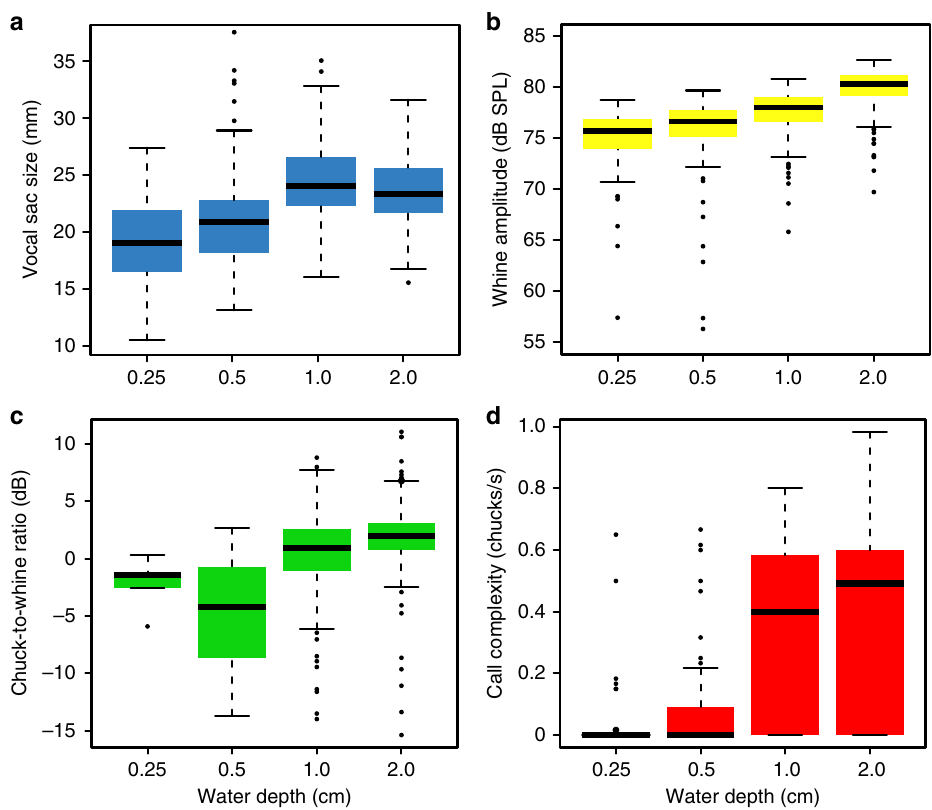
Fig. 1 Water depth limits signal production. Water depth treatment in fl uenced vocal sac width at maximum in fl ation a . Males in fl ated their sacs (and lungs) to lesser extent in shallow water. Water depth treatment also affected peak-to-peak amplitude of the whine component of the call ( b ), the chuck-to-whine ratio ( c ), as well as the total number of chucks produced ( d ). Males in deeper water were able to call louder, with more and relatively louder chucks. Boxplots are based on raw data and x-axes depict different water depth treatments. All call parameters increase linearly with water depth (GLMM, all P < 0.001, see also Supplementary Table